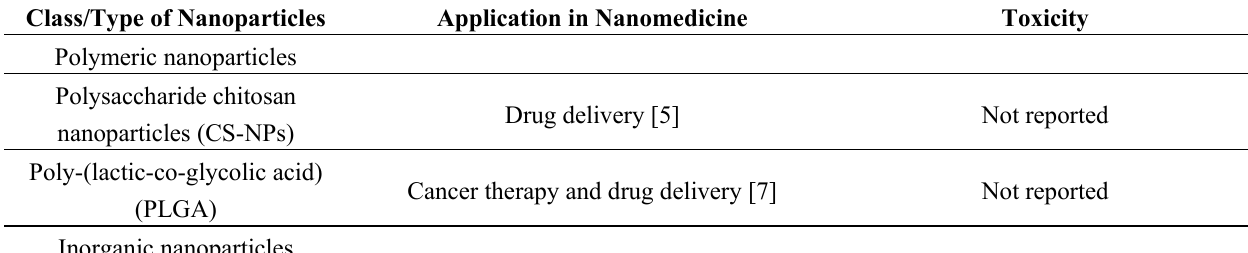
Table 1. Overview of the different types of nanoparticles used in nanomedicine, and the toxicity